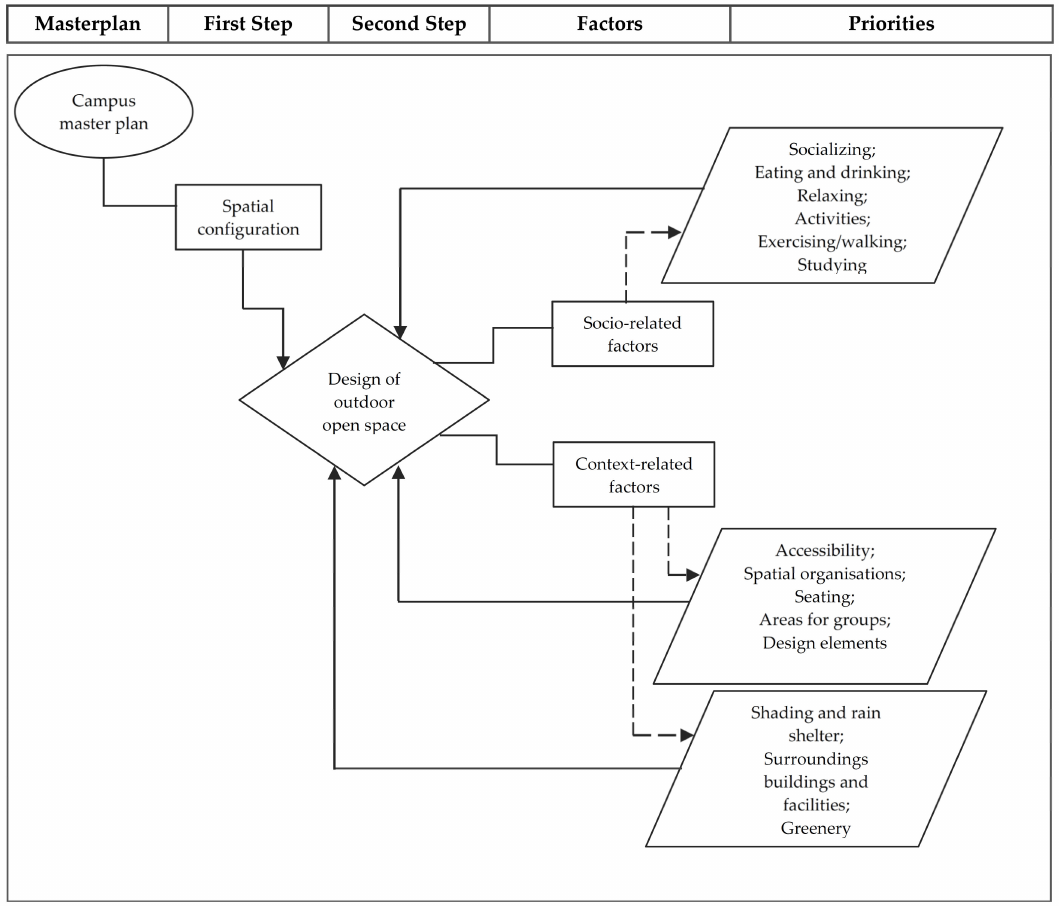
Figure 16. General framework for outdoor open spaces on campus from students’